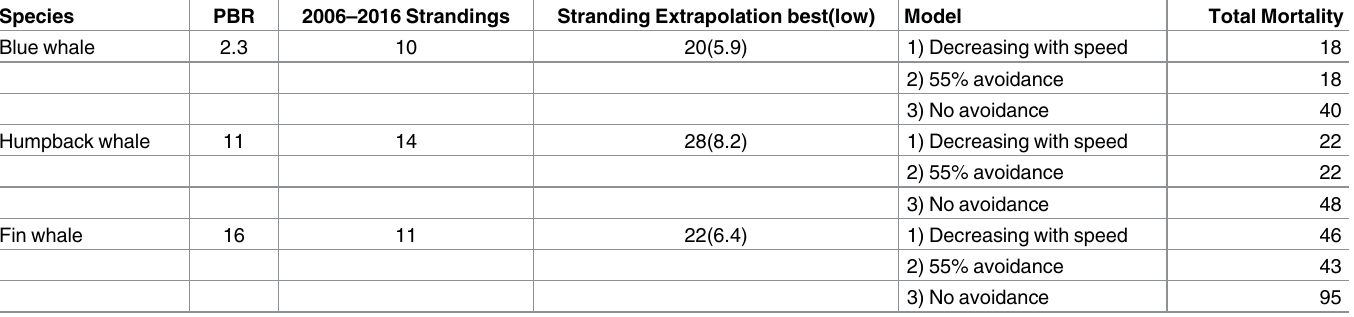
Table 2. Total study area mortality estimates(July-December) for each species and three different models incorporating different estimatesof col- lision avoidance. Potential Biological Removal (PBR) limits (annual)are includedfor each species for reference. Strandingextrapolations (annual)are basedon 5% (best) and 17% (low) carcass recovery